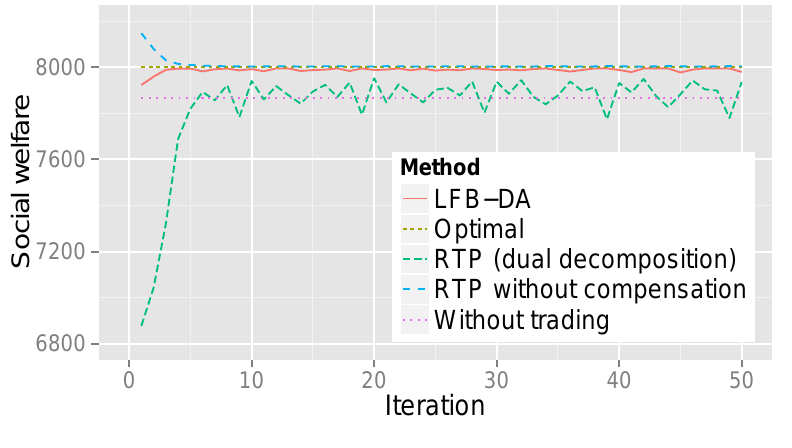
) − 1 = θ = 0 . β t k i ∈ N i